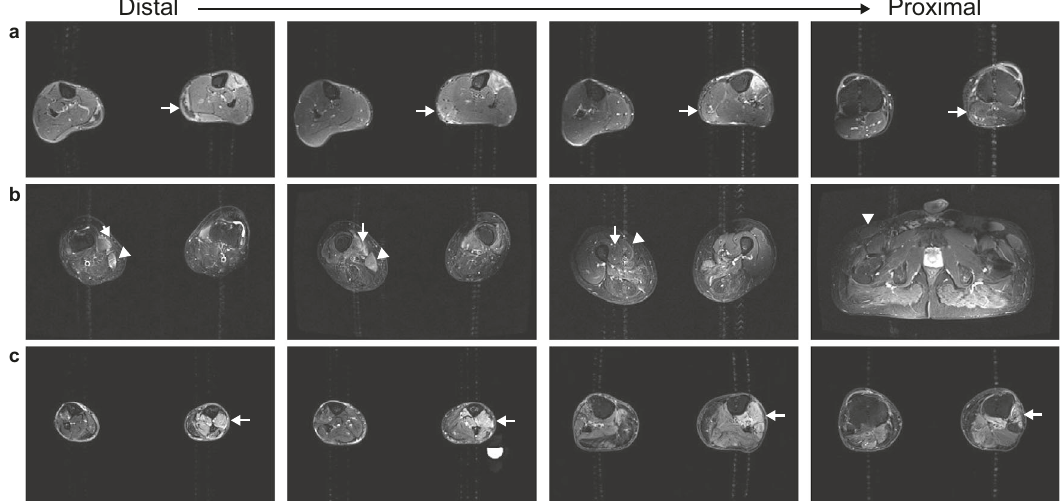
Fig. 8 Typical examples of hyperintensity patterns along the muscle length at a turbo-inversion recovery magnitude (TIRM) sequence. The order of the images from distal-to-proximal is indicated at the top of the fi gure. a Lower legs of a 52-year-old male facioscapulohumeral muscular dystrophy (FSHD) patient showing TIRM hyperintensity in the distal part of the gastrocnemius lateralis and a normal appearance of this muscle at the proximal muscle end (arrows). b Upper legs of a 47-year-old male FSHD patient with TIRM hyperintensity localised in the distal part of the sartorius (arrow heads) and vastus medialis (arrows) with a normal appearance at the proximal end of these muscles. c Lower legs of a 62-year-old male FSHD patient showing TIRM hyperintensity over the whole muscle length for all lower leg anterior compartment muscles